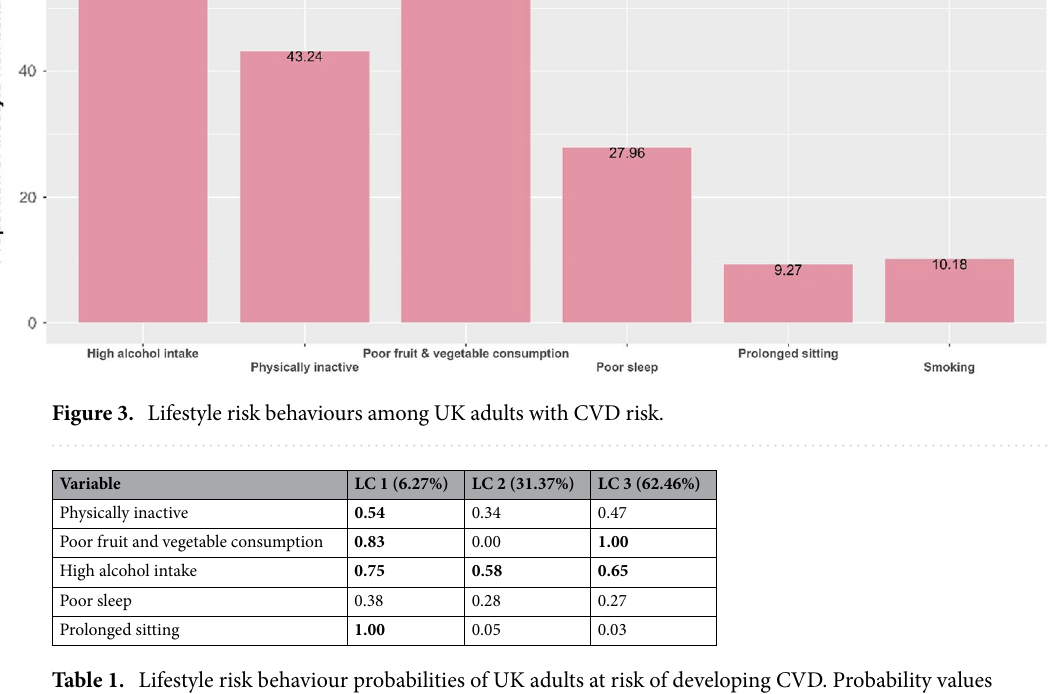
Table 1. Lifestyle risk behaviour probabilities of UK adults at risk of developing CVD. Probability values ≥ 0.50 are in bold.